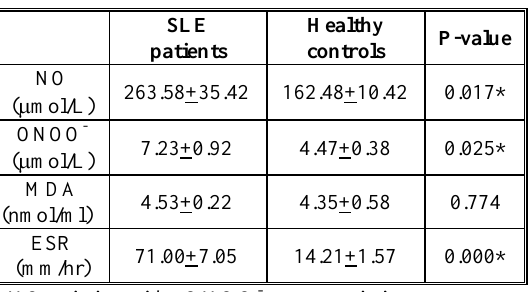
Table 2 : Nitric oxide, peroxynitrite